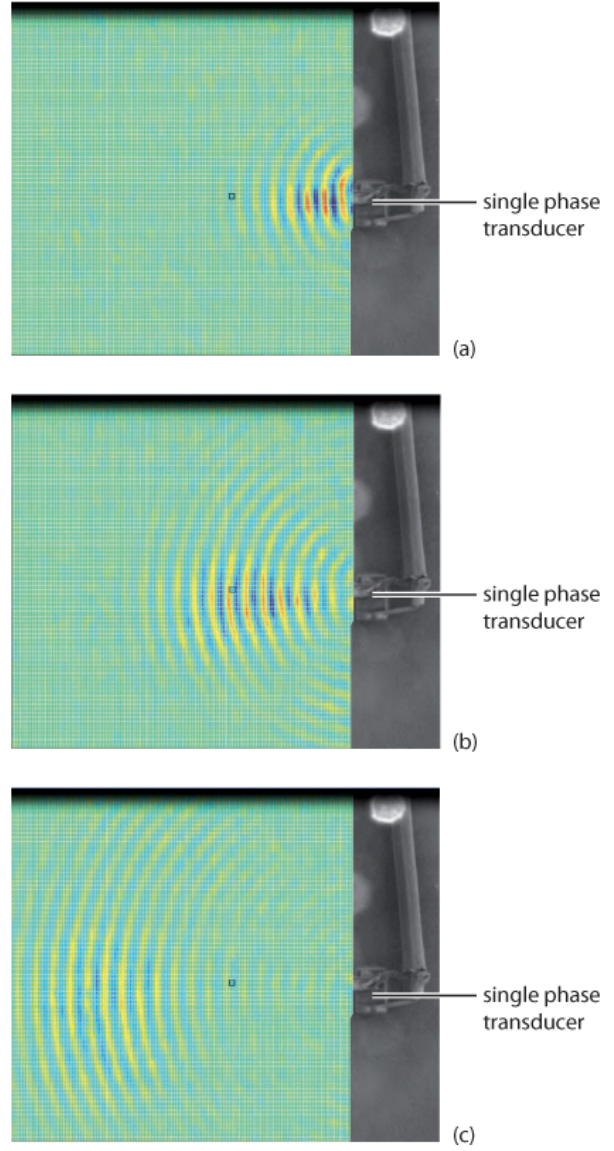
Figure 5. Scanning Laser Doppler vibrometer images of the Lamb wave excitation of a single-phase transducer on a glass plate after (a) 3.71 µ s, (b) 8.4 µ s and (c) 14.65 µ s after the excitation signal.